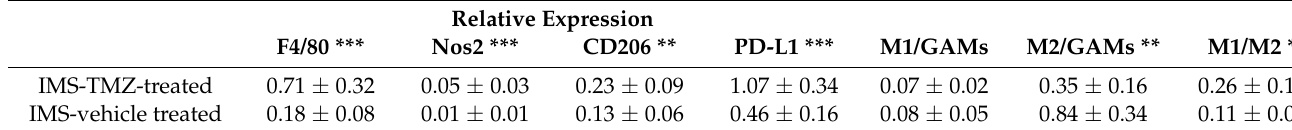
Table 1. Relative normalised expressions obtained in qPCR studies with IMS-TMZ and IMS-vehicle-treated samples: average ± SD of F4/80, Nos2, CD206, and PD-L1 genes, and ratios of M1/GAMs, M2/GAMs, and M1/M2. Significant differences between groups are indicated by asterisks (*** p ≤ 0.001, ** p < 0.005, and * p < 0.05)).